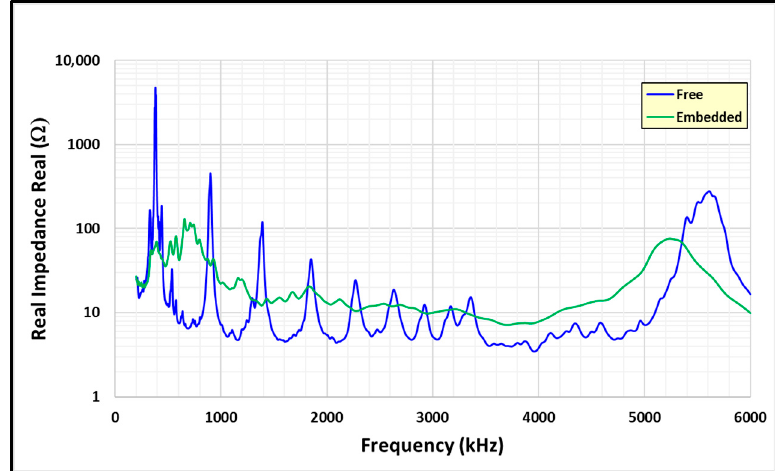
Figure 21. ( a ) Free sensor, ( b ) embedded sensor, baseline impedance results.